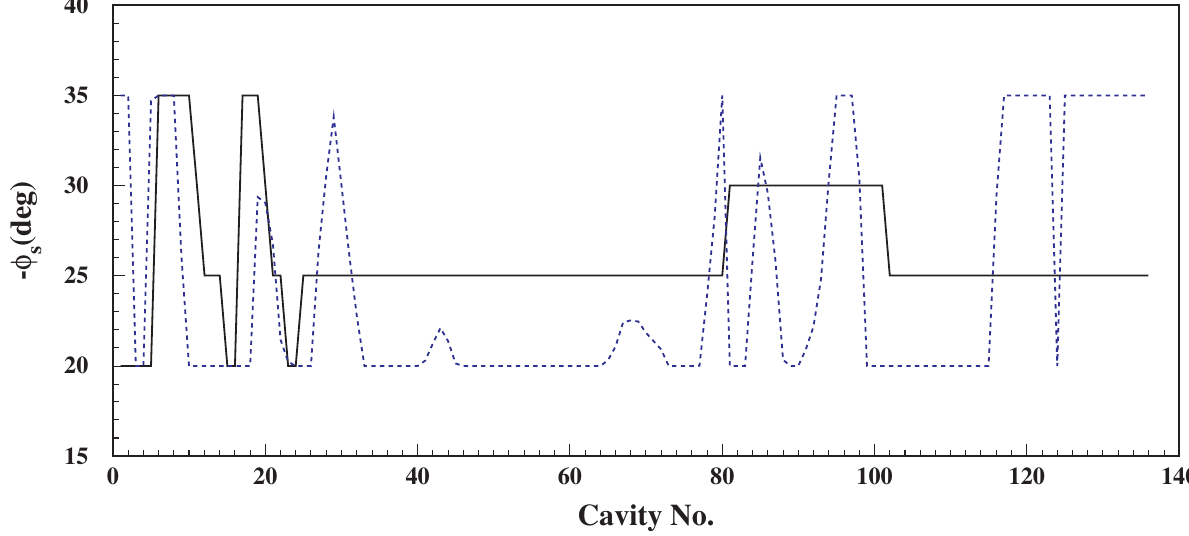
FIG. 7. (Color) Cavity phases (cid:1) (cid:2) as a function of the cavity number along the medium- (cid:1) section of the RIA driver linac. The solid s curve corresponds to the original phases obtained by manual tuning and used as initial values for the automatic tuning procedure and the dashed curve shows the final phases obtained by the